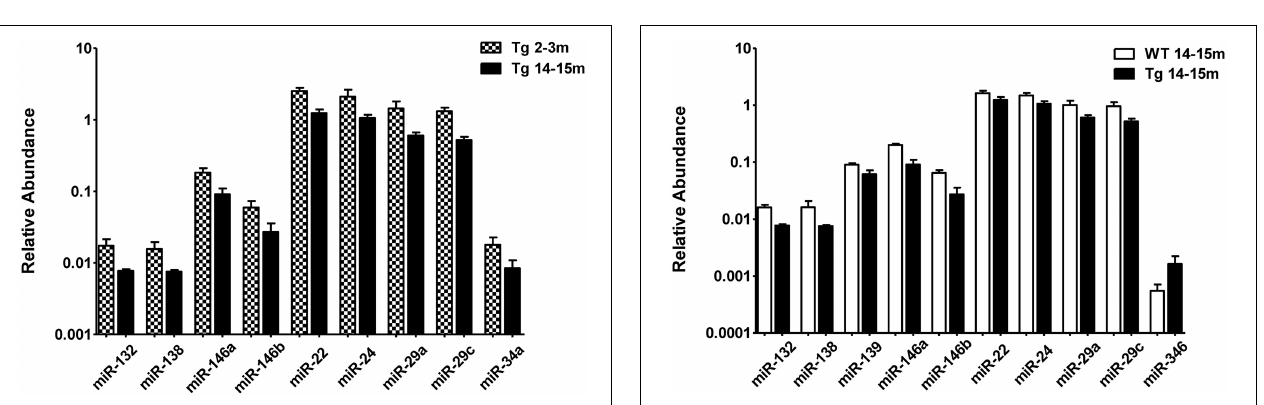
groups of each of the 19 matching miRNAs. Relative abundance was calculated considering the difference of the Ct of each miRNA and the Ct of the miR-39 of C. elegans mimic ( (cid:2) Ct) using the formula 2 − (cid:2) Ct . miR-39 from C. elegans was used as spike-in control in all qRT-PCR experiments. Only miRNAs that showed statistical differences when comparing young and old WT or Tg subjects are shown in the graph; t -test; p < 0 . 05.